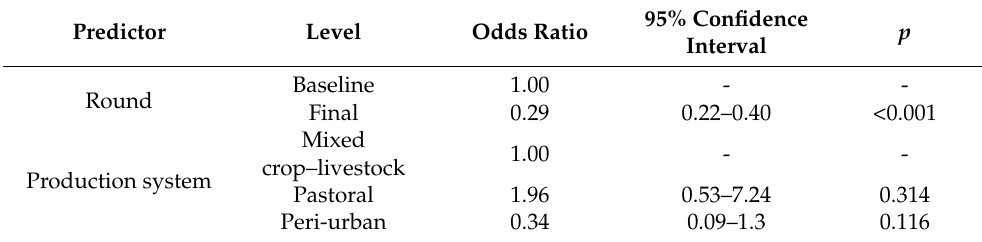
Table 16. Calf respiratory disease risk model